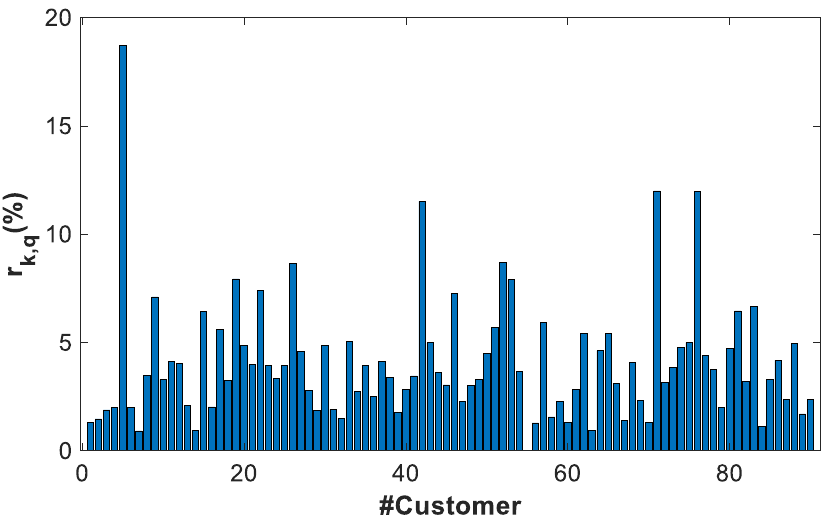
(cid:92) Y AAAA - BA , of sub cluster k = AAAA-BA.